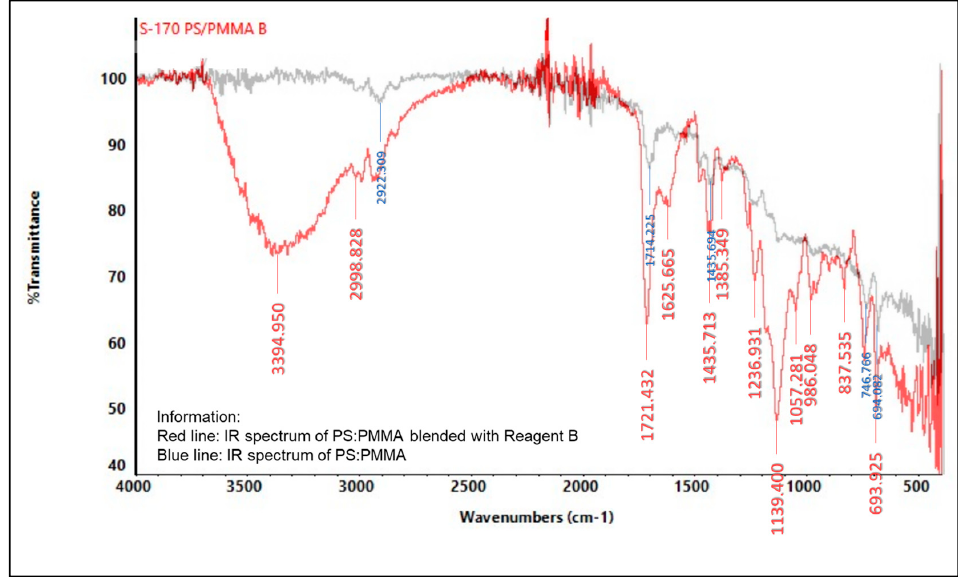
Figure 8. IR spectrum comparison of pure PS:PMMA and blended PMMA with reagent B (concen- trated HCl).